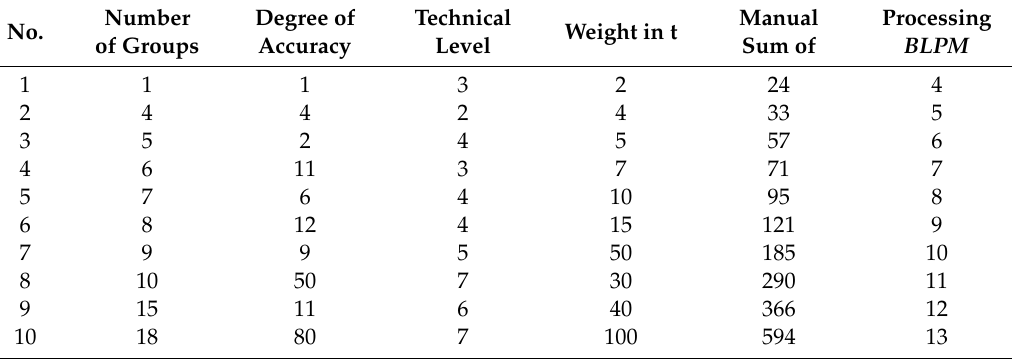
Table 4. Values entered to validate the mathematical